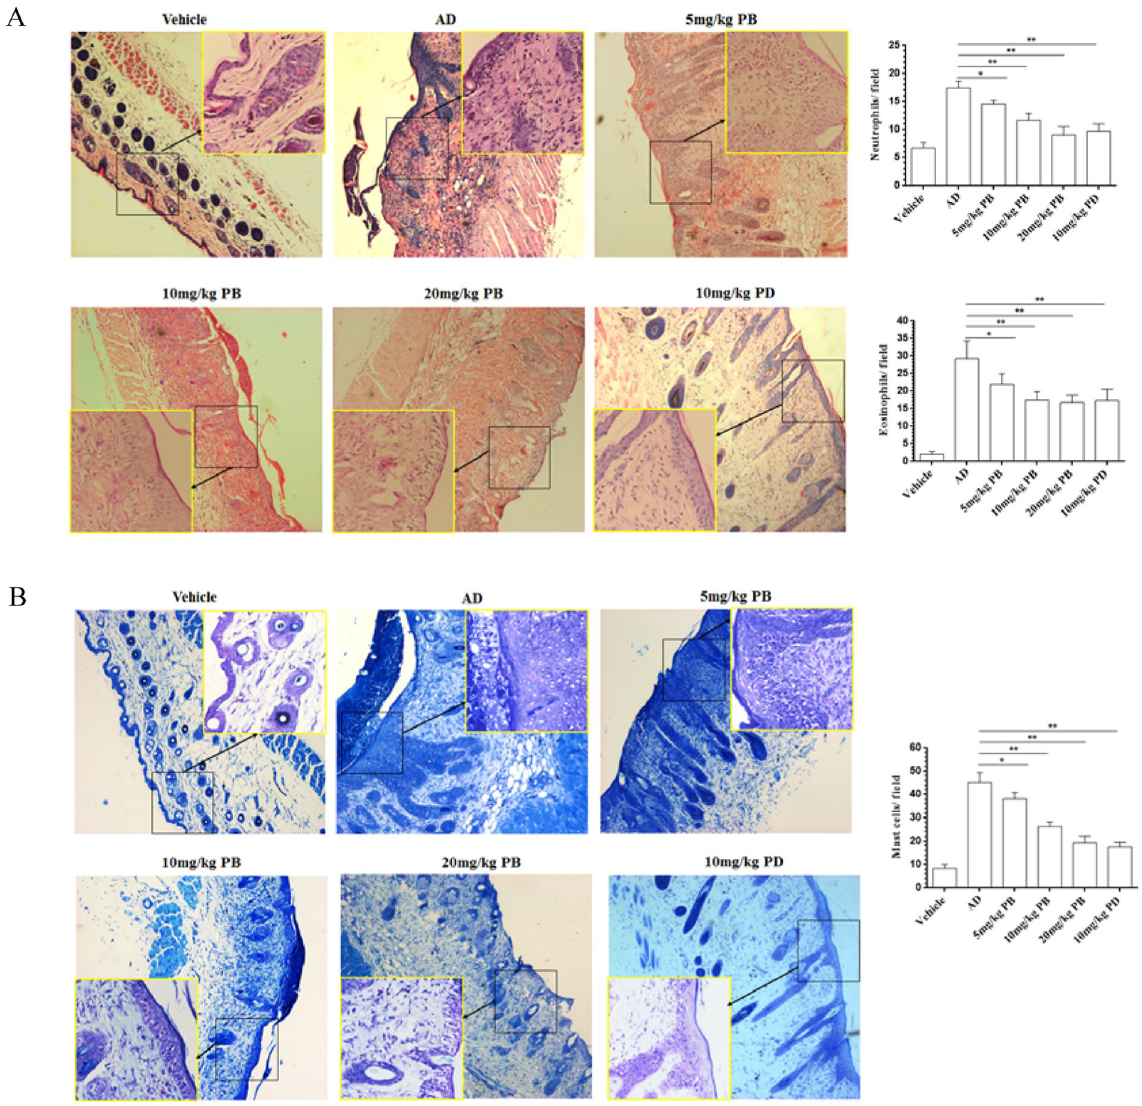
Figure 2. Histological features of skin tissues. ( A ) The sections from NC/Nga mice were stained with H&E staining. Representative dorsal skin photographs captured showing comparison of AD-like skin lesions. Magnification 40 × , inset 200 × . ( B ) The levels of mast cells by toluidine blue staining. Magnification40 × , inset 200 × . In these experiments, we used 3 slides per mouse, and observed 3 fields per slide. Data are representative of two independent experiments and presented as mean ± SD of n = 8 mice per group. * p < 0.05, ** p < 0.01. Vehicle, intact mice with saline treatment; AD, DNFB-sensitized and challenged mice; PB, pseudolaric acid B; PD,